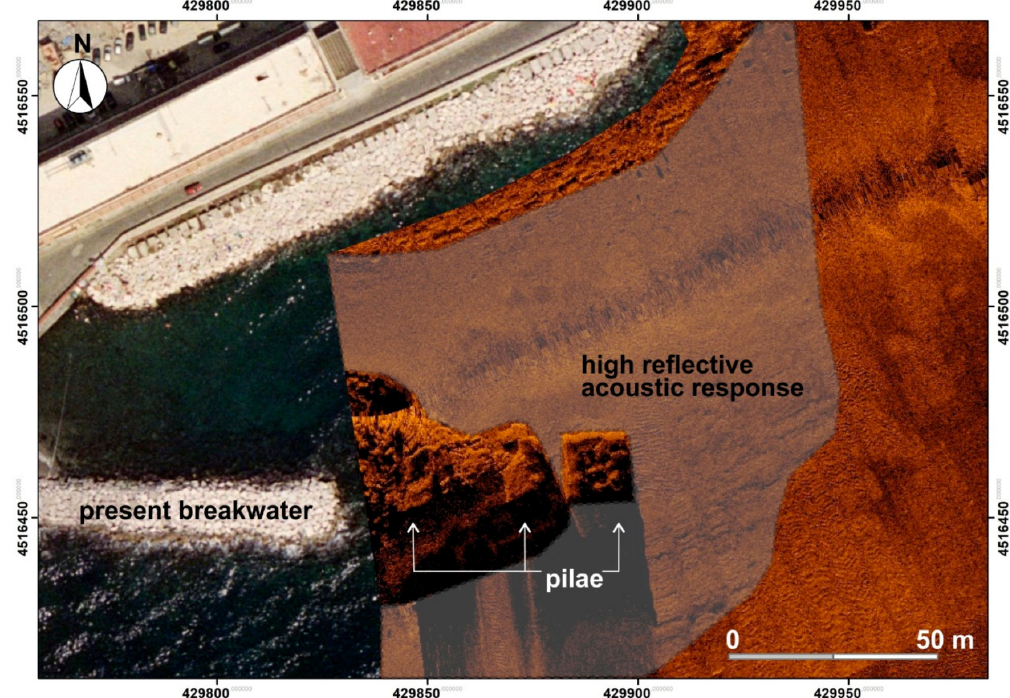
Figure 14. SSS map of the study area, with a seabed characterisation and the location of the archaeological